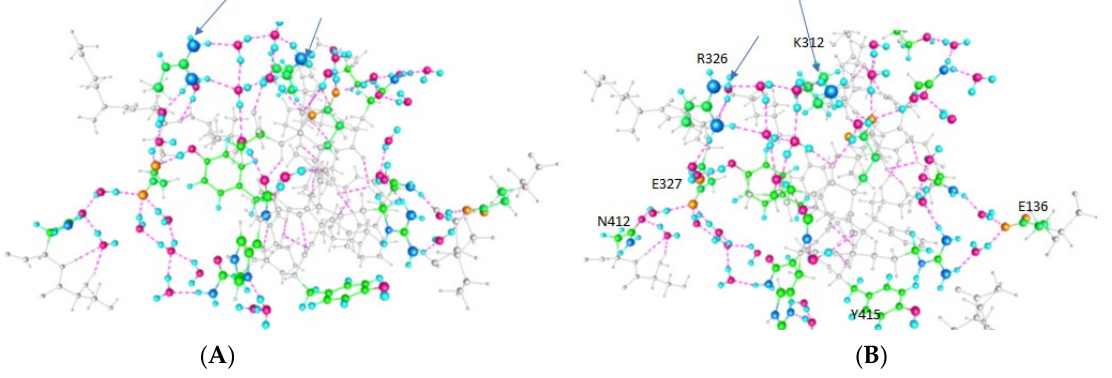
Figure 2. This figure shows two views (system rotated to make it possible to see all the residues clearly) of the results of the optimization with protons on the almost adjacent residues K312 and R326. Key residues are labeled in ( B) , which is the same as ( A ) but rotated 90°. The energy for this result turns out to be more than 30 k b T above the other two cases. The two charged residues separate by more than 2 Å beyond the X-ray value. Both proton paths are easily visible, by following the colored residues, and the connecting (meaning hydrogen bonded) water molecules. The upper path includes K312 and R326, and, in this optimization, ends at N412, from which it has access to the conserved PVPV sequence. The lower path, which includes Y415, continues via H418 to N414, which likewise has access to the PVPV sequence. Other amino acids included in the optimization, but not the proton path, are shown in gray. In addition to the upper and lower paths, there is a crossover that apparently allows protons to switch paths; this is the vertical path in the left ‐ center. The gate is on the left, the VSD on the right and above. Color code: Carbon, green; nitrogen, large blue sphere; hydrogen, small pale blue spheres; oxygen, magenta. The added protons are not visible, but their positions are indicated by the arrows.